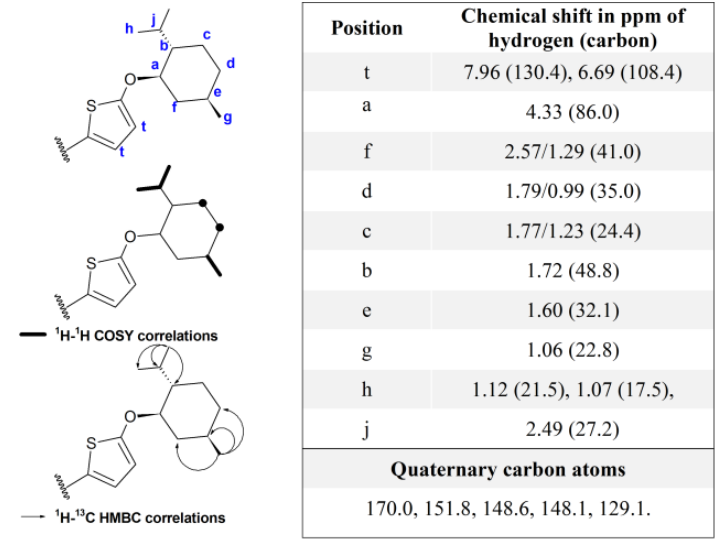
Figure 1. Signals for hydrogen and carbon atoms of 2 according to NMR spectroscopy and correlations observed in two-dimensional COSY, HSQC, and HMBC experiments; COSY—Correlation Spectroscopy, HSQC—Heteronuclear Single Quantum Correlation, HMBC—Heteronuclear Multiple Bond Correlation.